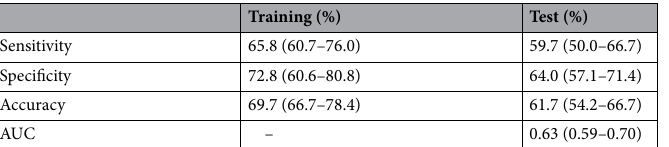
Table 7. Assessment of the predictive performance of the predictive model for training and testing data in the whole-lung radiomics analysis with the synthetic minority over-sampling technique. AUC area under the curve.